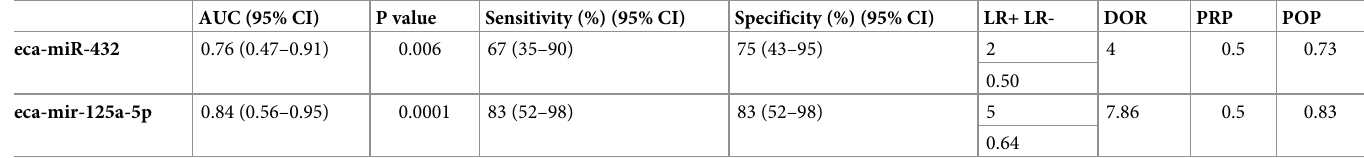
Table 2. ROC curve analysis for miRNAs as prognostic biomarker in the prediction of sarcoid onset in healthy 3-year old male horses. AUC (95% CI) P value Sensitivity (%) (95% CI) Specificity (%) (95% CI) LR+ LR- DOR PRP